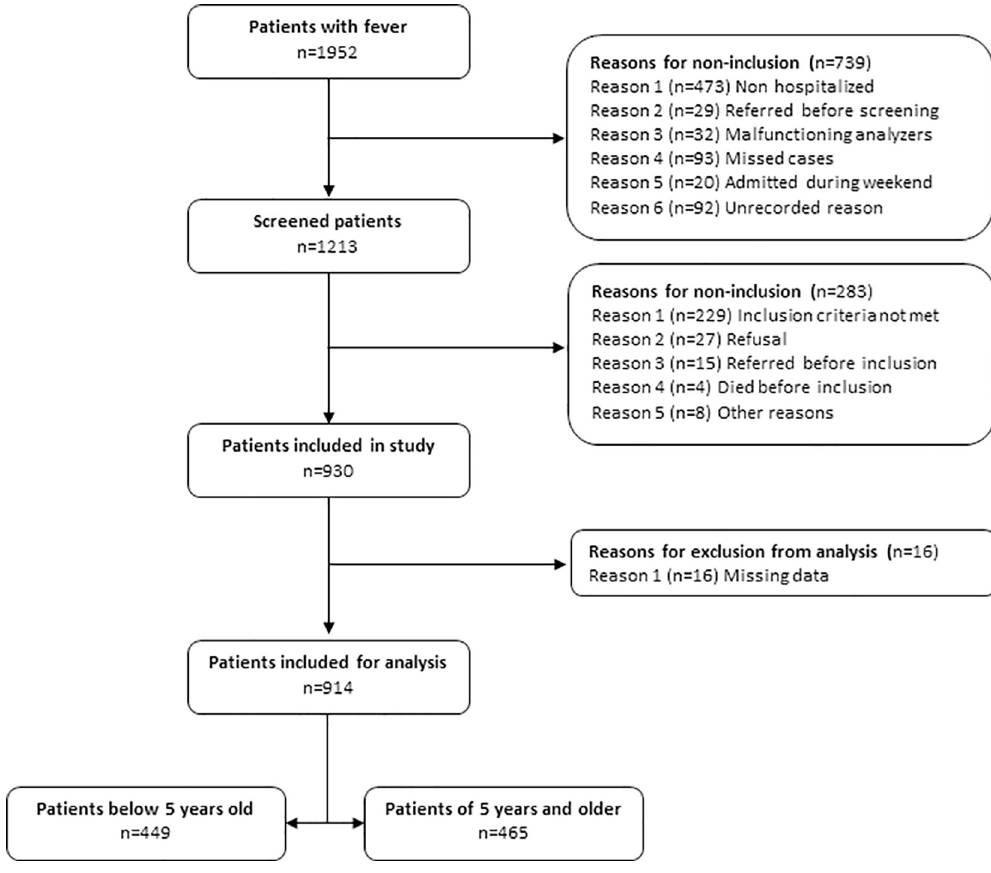
Fig 1. Flow chart of